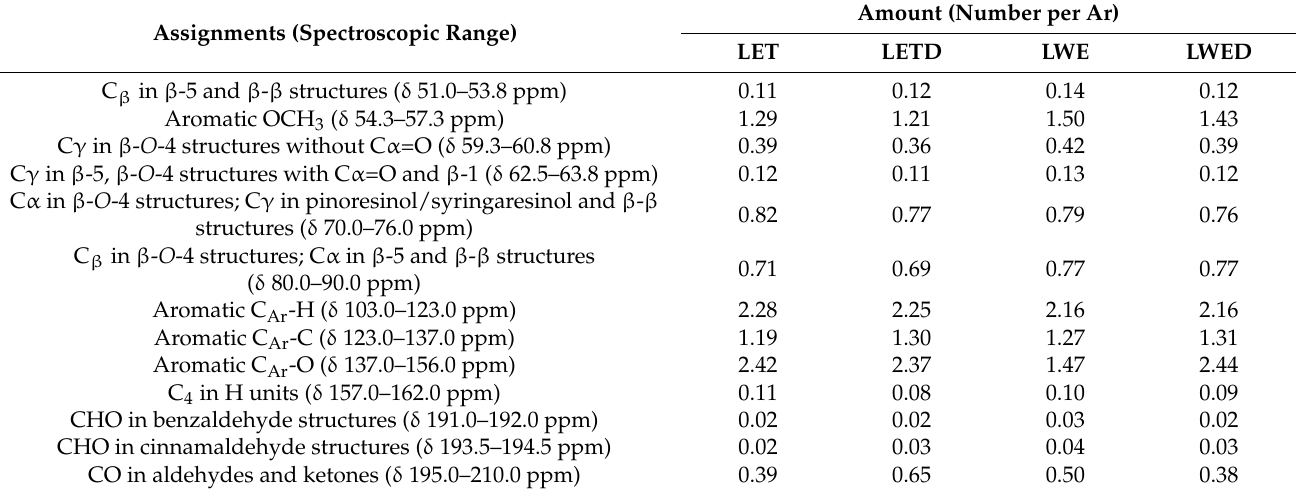
Table 2. Assignments and quantification of the structure/linkages and functional groups identified by 13 C NMR in the different lignin